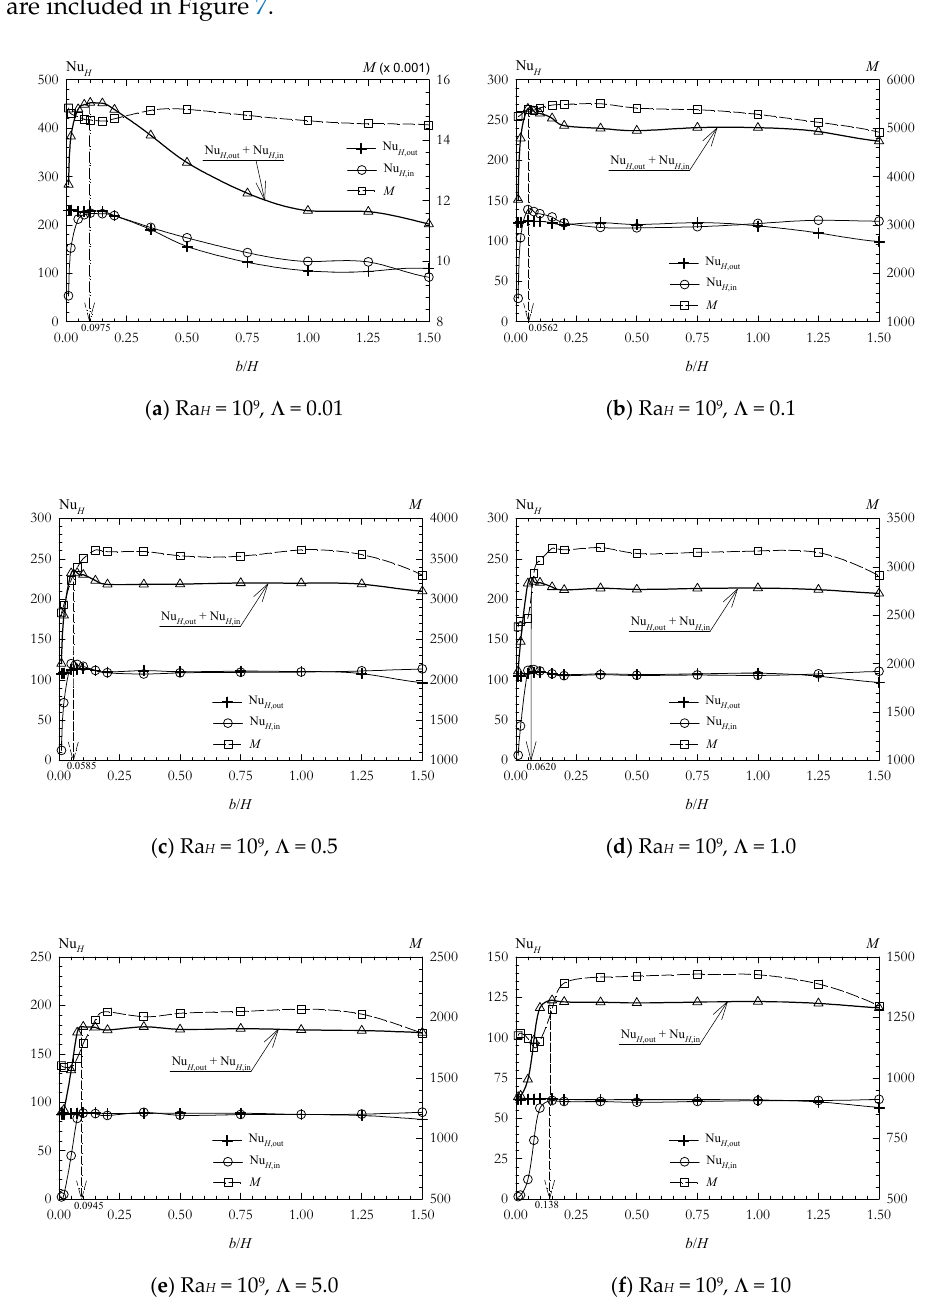
Figure 7. Evolution of average Nusselt number Nu H and dimensionless mass-flow-rate M as a function of aspect ratio b / H , for Ra H = 10 9 , and di ff erent values of heating parameter Λ , with indication of the thermally optimal points. Configuration is given in Figure 1b. Note that in (a), values of M are divided by 10 3 .